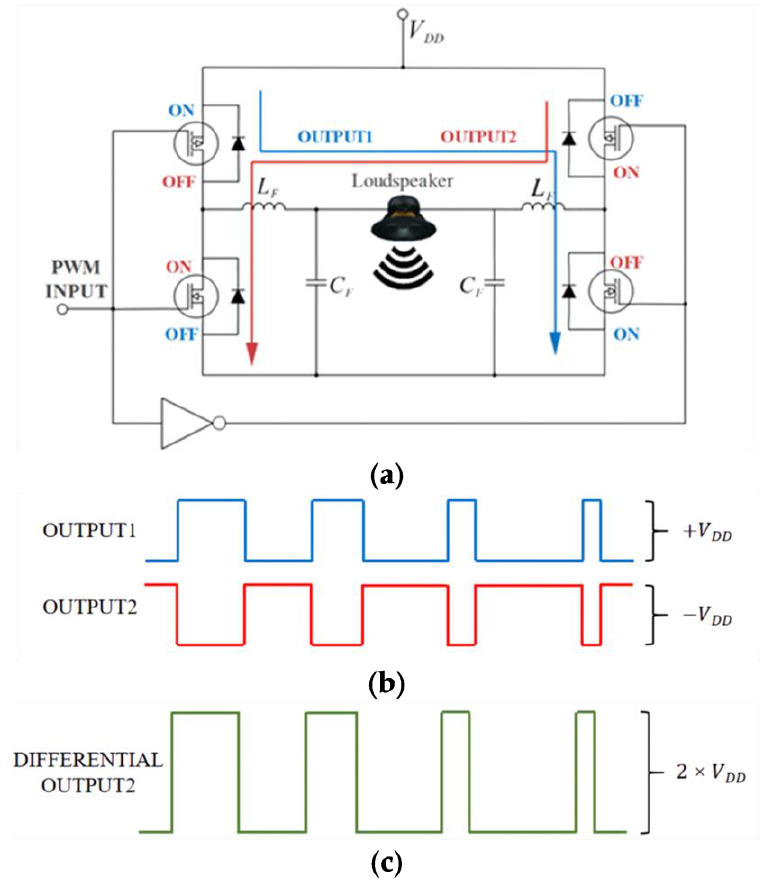
Figure 13. A traditional full-bridge Class D output stage ( a ) and ( b ) and the waveform ( c ).